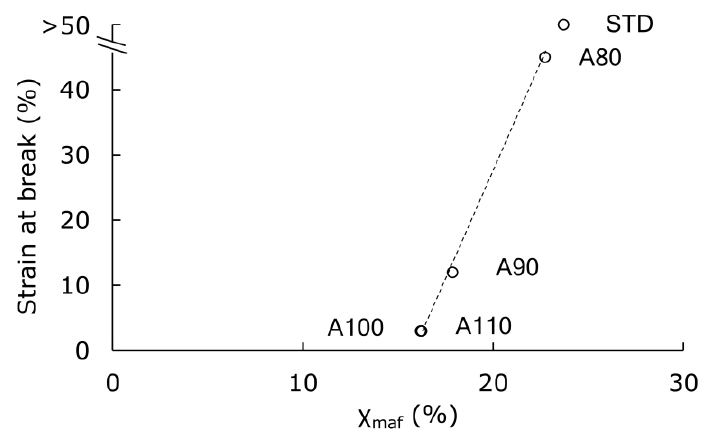
Figure 8. The relationship between mobile amorphous (χ maf ) and strain at break for annealed PLA after the 1 h hydrolysis at 70 °C and 95% RH.